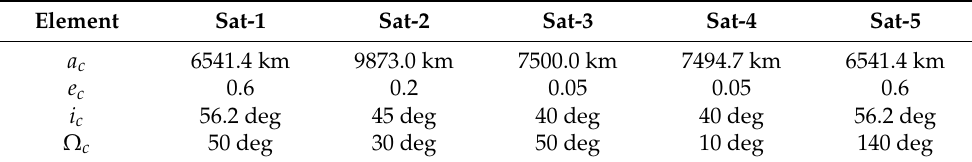
Table 3. Orbital elements for the satellites of the constellation. Element Sat-1